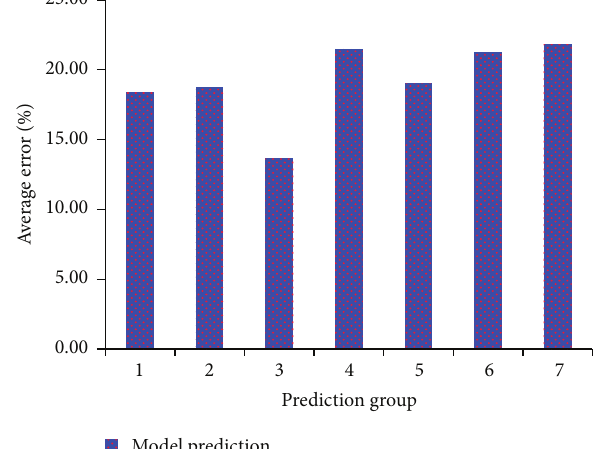
Figure 9: Prediction error of multi-nonlinear-regression model.